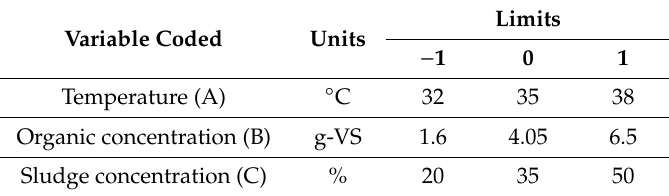
Table 1. Independent variables with their